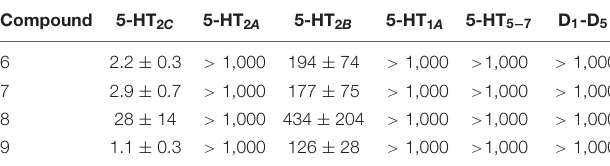
TABLE 1 | Binding affinities of 7-halogen isoindolones at serotonin (5-HT 1 A -5-HT 7 ) and dopamine (D 1 -D 5 ) receptors ( Ki , nM) a